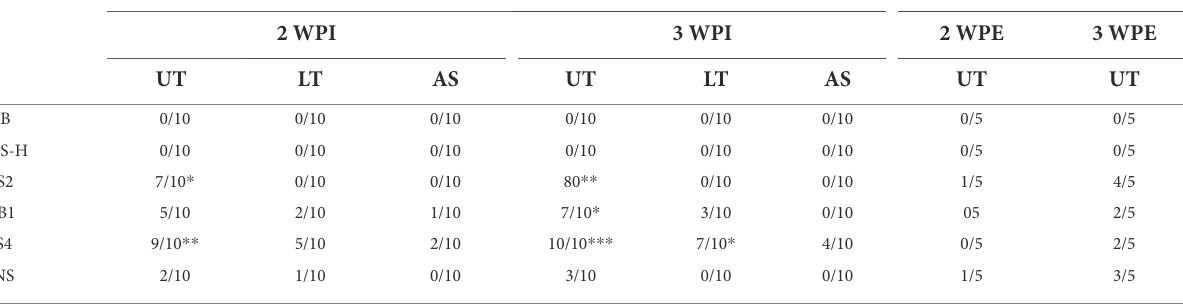
Data are presented as number of cultures showing color change/number of all the cultures in the same group. * p < 0.01, ** p < 0.001, *** p < 0.0001 (two-tailed Fisher’s Exact test). WPI, weeks post inoculation; WPE, weeks post exposure; AS2, MS-H reisolate containing reversion in obgE gene; AB1, MS-H reisolate containing reversions in obgE and oppF genes; TS4, MS-H reisolate containing reversions in obgE , oppF and gapdh